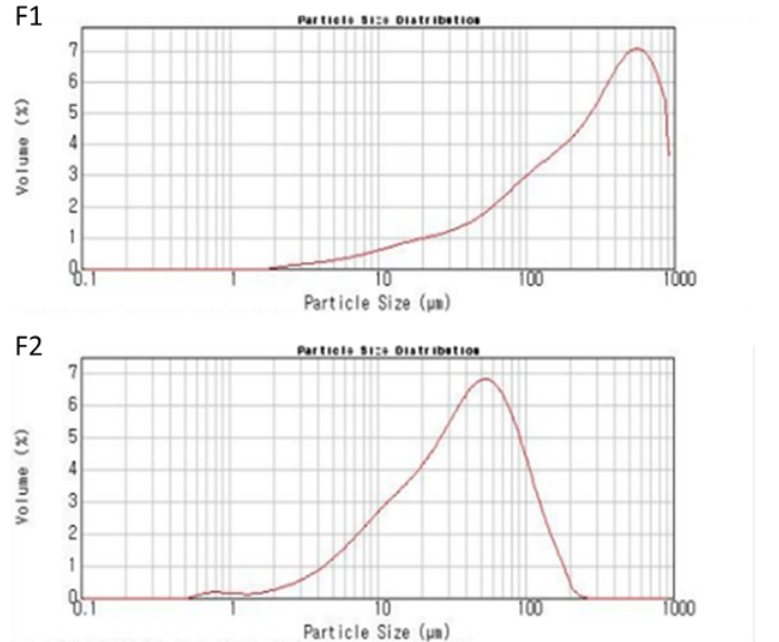
Fig 2. Size distribution of coarse and ultrafine AGN particles (F1 and